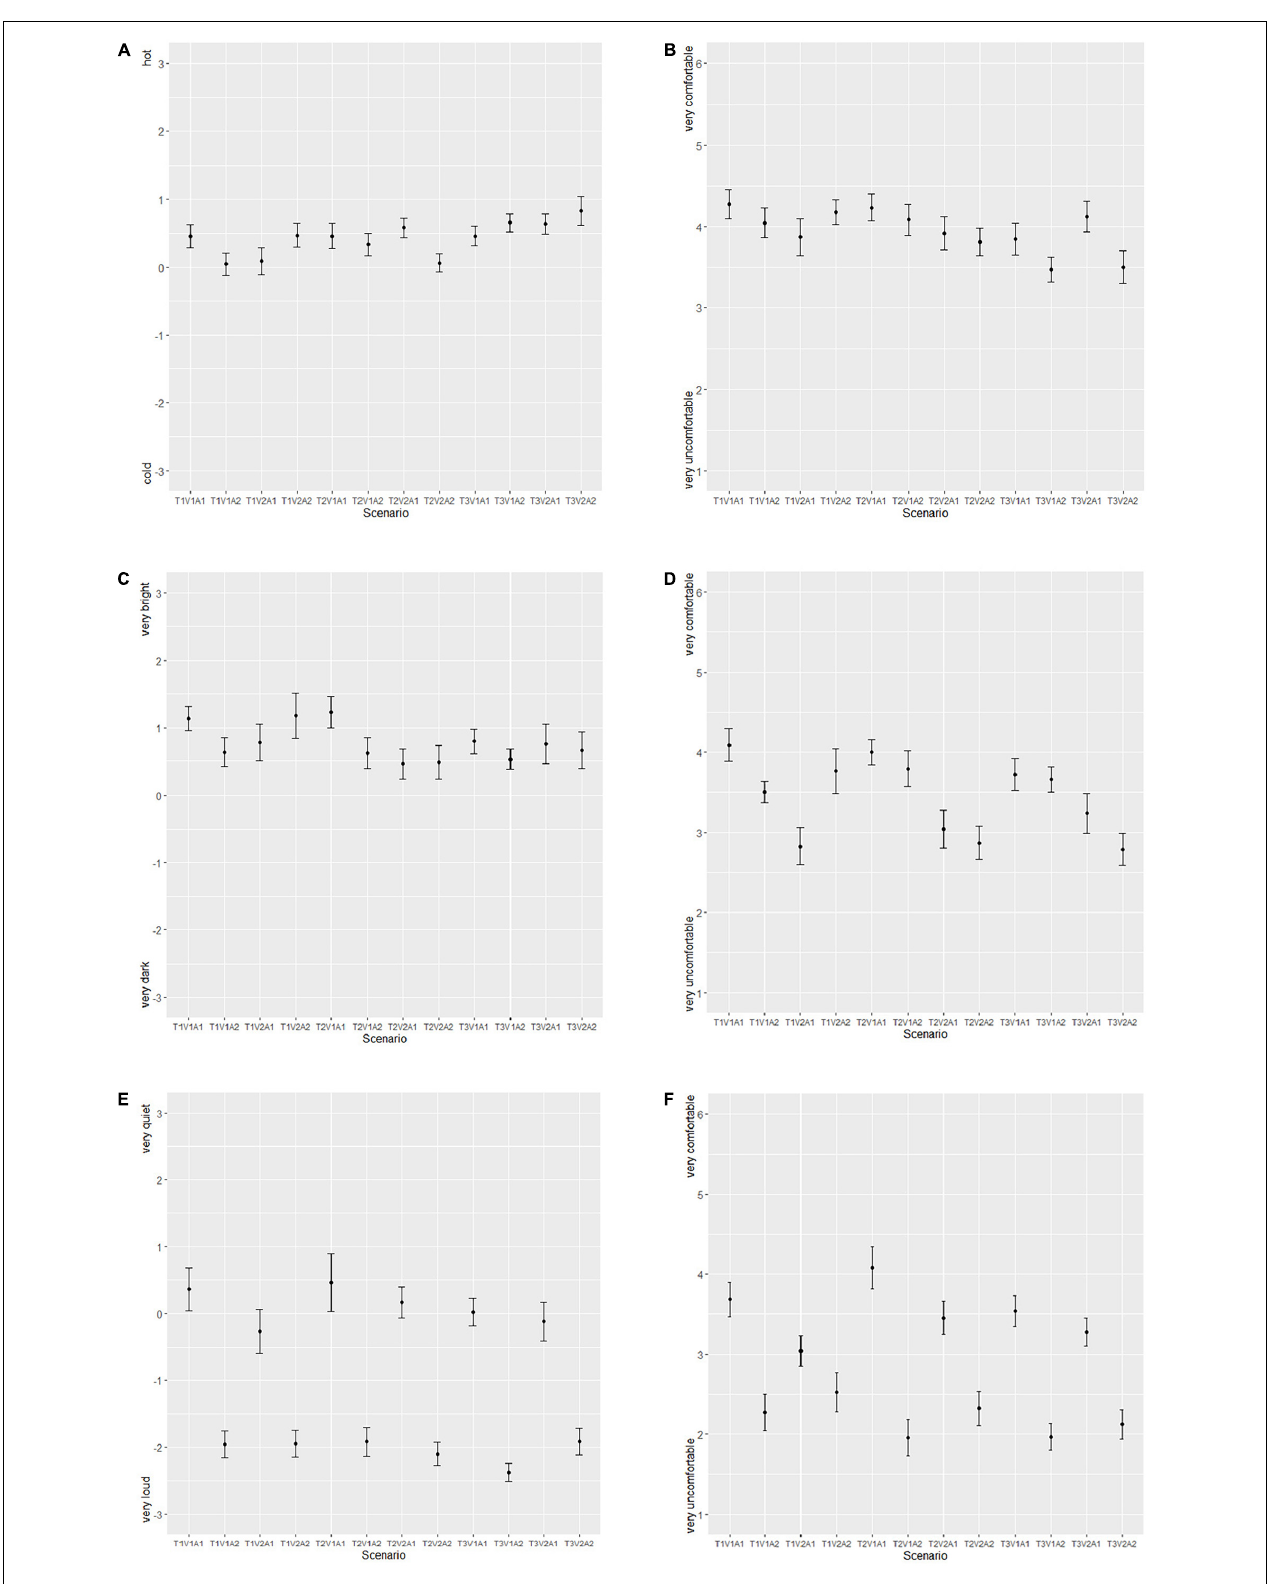
FIGURE 3 | The thermal sensation (A) and thermal comfort (B) , visual sensation (C) and visual comfort (D) , and acoustic sensation (E) and acoustic comfort (F) of participants.